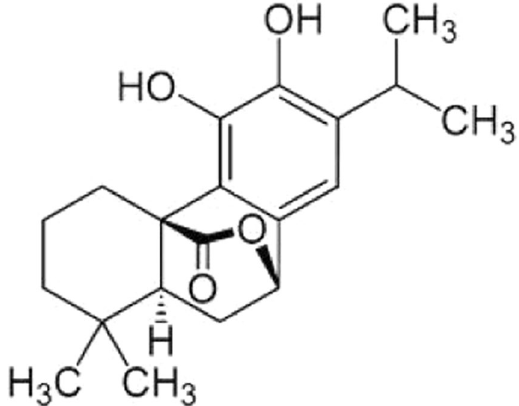
Figure 1. The chemical structure of carnosol.